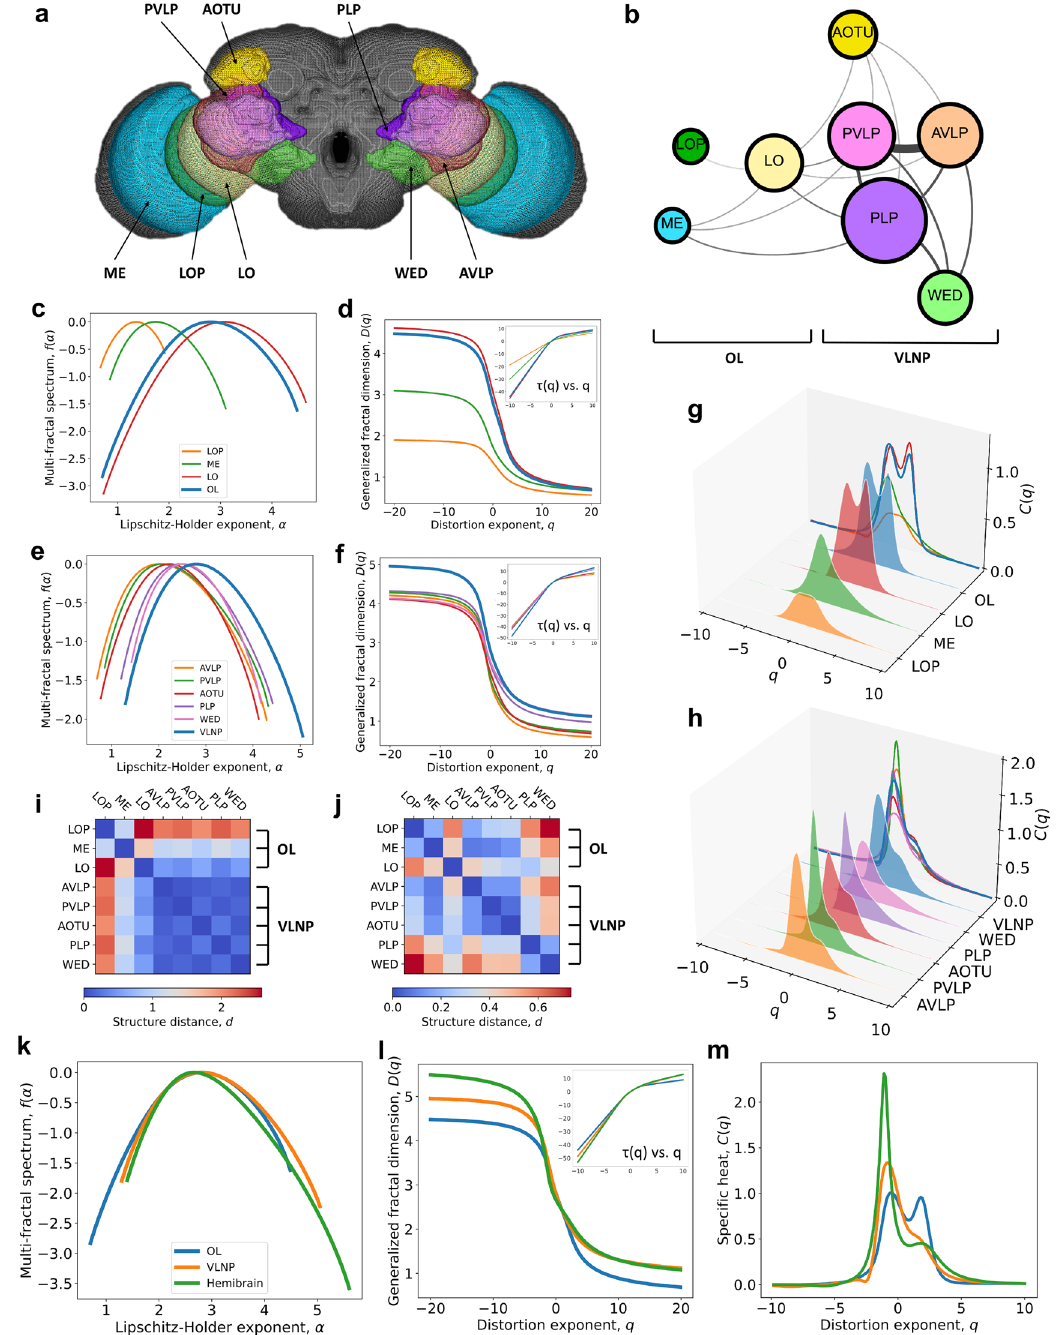
Figure 4. NMFA of the adult Drosophila visual system. ( a ) The composition of the Drosophila visual system. ( b ) The connections between different regions in the Drosophila visual system. The area of the circle characterizes the size of the corresponding brain regions (i.e., number of neurons) and the width of the line between two circles characterizes the connection between the brain regions (i.e., number of neural connections shared by two regions). ( c–h ) The comparisons of the multifractal behavior between the networks in the optic lobe (OL) and the ventrolateral neuropils (VLNP). ( c,d,g ) The comparisons of the multifractal spectra ( c ), the mass exponent ( d ), generalized fractal dimension ( d ), and specific heat distribution ( g ) of the networks in the OL. ( e,f,h ) The comparisons of the multifractal spectra ( e ), the mass exponent ( f ), generalized fractal dimension ( f ), and specific heat distribution ( h ) of the networks in the VLNP. ( i,j ) The structure distance between the regional networks when q < 0 ( i ) and q > 0 ( j ) respectively. ( k–m ) The comparisons of the multifractal behaviors between the OL, VLNP, and the whole hemibrain. ( k ) The multifractal spectrum. ( l ) The generalized fractal dimension and mass exponent distribution. ( m ) The specific heat